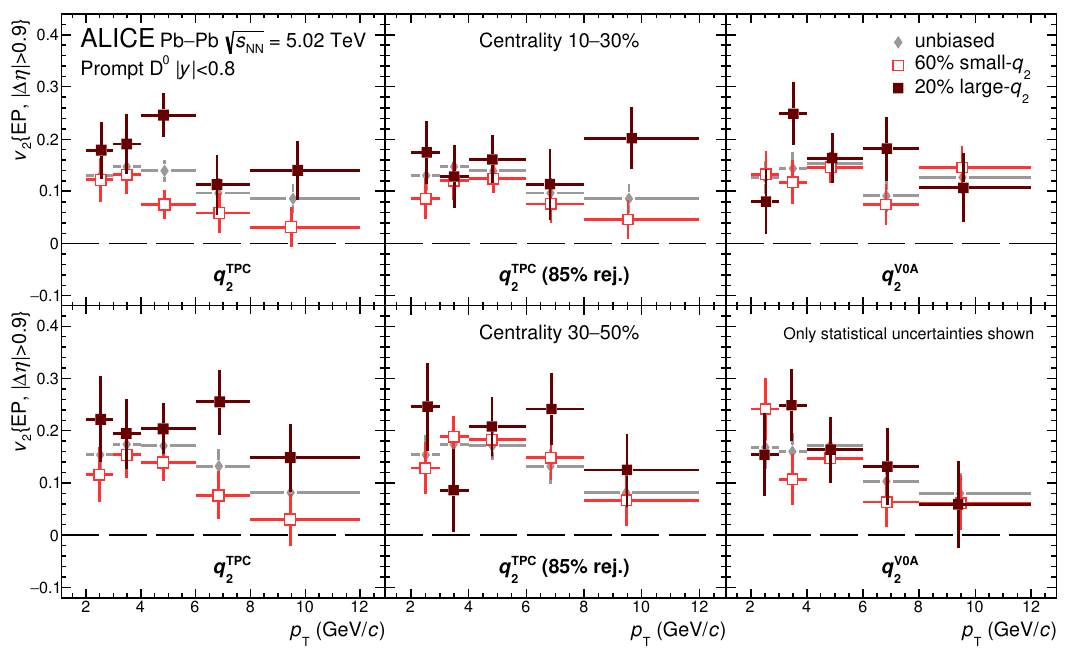
Figure 4 . Comparison between the D 0 v 2 values measured in the unbiased sample and in the two event-shape classes obtained using TPC and V0A to compute q 2 , for the 10{30% (top row) and 30{50% (bottom row) centrality classes. Only statistical uncertainties are